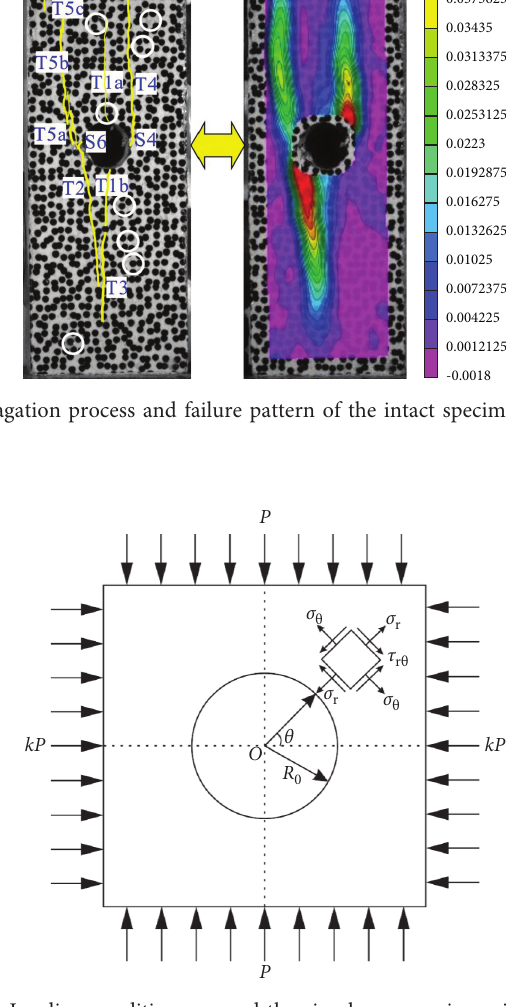
Figure 17: Loading conditions around the circular cavern in an infinite